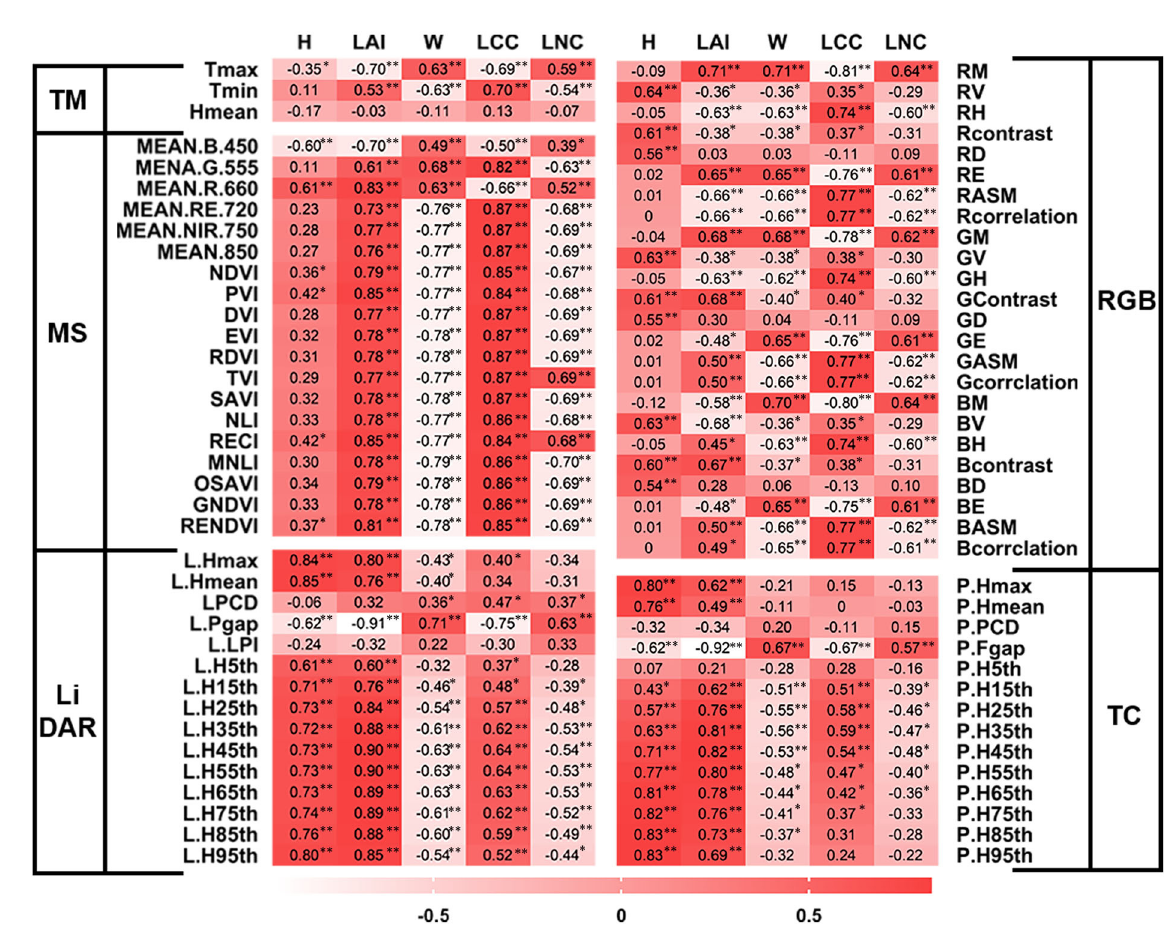
BASM, and BCorrelation variables of RGB were selected for modeling; MEAN.NIR. 750, MEAN. 840, EVI, SAVI, RDVI, MNLI, and GNDVI variables of MS were selected for modeling; Tmax and Tmin variables of TM were selected for